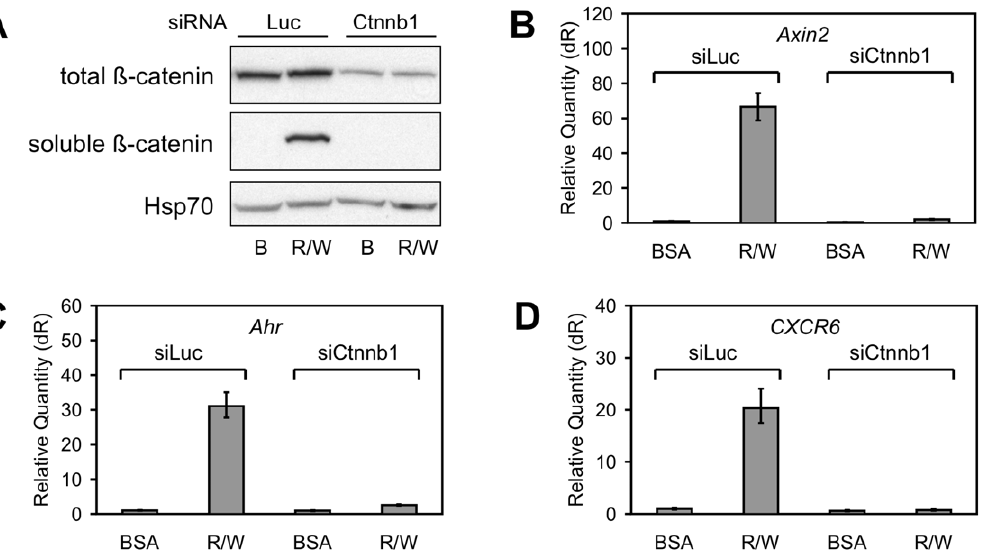
Figure 5. Knockdown of b -catenin inhibited up-regulation of genes by Rspo2 and Wnt3a. ( A ) C57MG cells were pre-treated with either luciferase or pooled Ctnnb1 siRNA reagent for 24 h prior to additional 24 h incubation with BSA or Rspo2 (10 ng/ml) plus Wnt3a (100 ng/ml). Total and soluble b -catenin and Hsp70 were detected as described in Fig. 4 legend. ( B–D ) Quantitative PCR analysis of Axin2 , Ahr and CXCR6 expression by C57MG cells after 24 h incubation with luciferase or pooled Ctnnb1 siRNA reagent followed by 24 h treatment with BSA or Rspo2 plus Wnt3a [experiment performed in parallel with (A), using the same reagent concentrations]. Results are means + / 2 S.D. of triplicate measurements from one of three representative experiments.